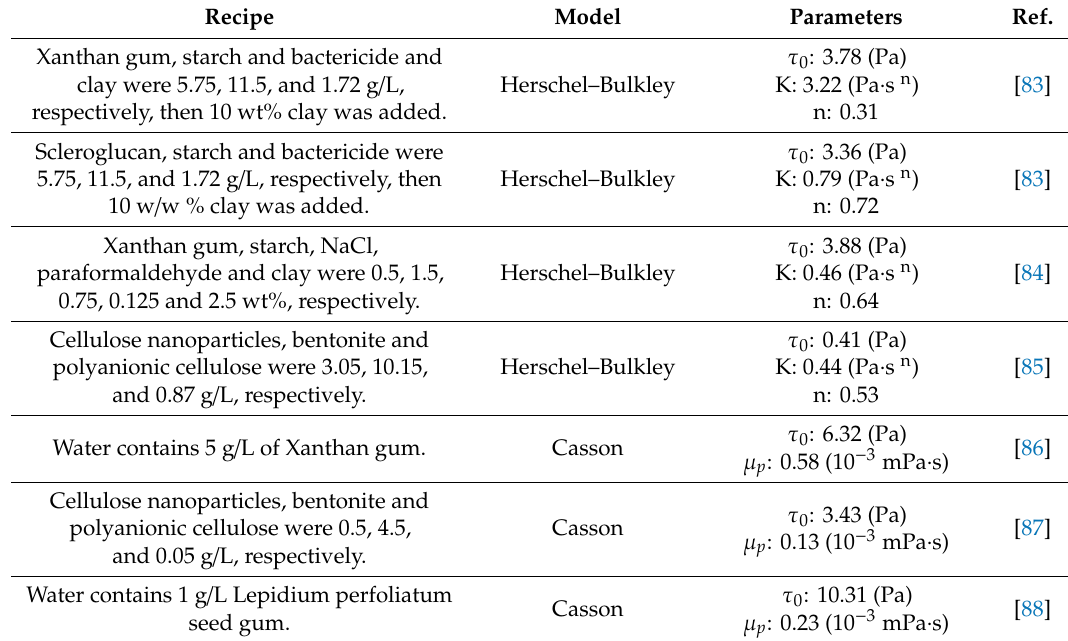
Table 3. The rheology properties of drilling fluids with biopolymer. Recipe Model Parameters Ref. Herschel–Bulkley